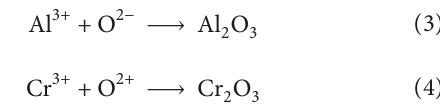
Figure 8: The curve of the friction coefficient varies with time of Inconel 617 alloy matrix and cladding at 200 ° C, 600 ° C, and 1000 ° C. 0.00.51.01.52.02.53.03.54.0